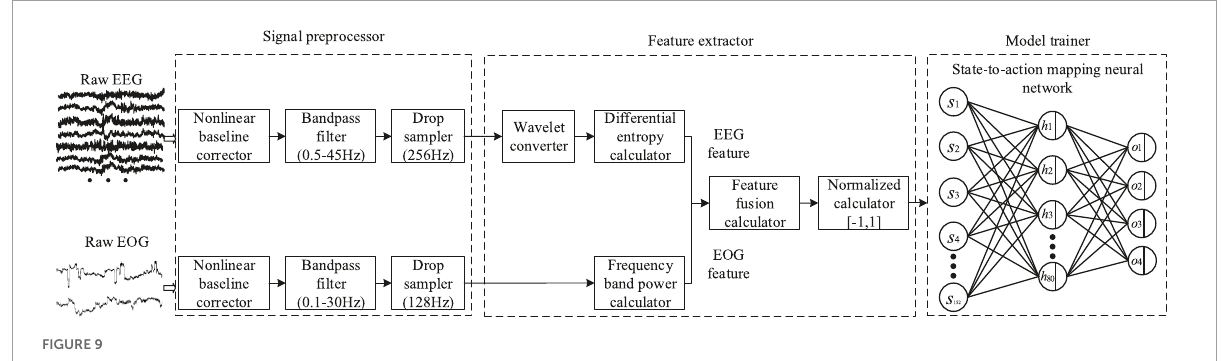
FIGURE9 Flow chart of data preprocessing